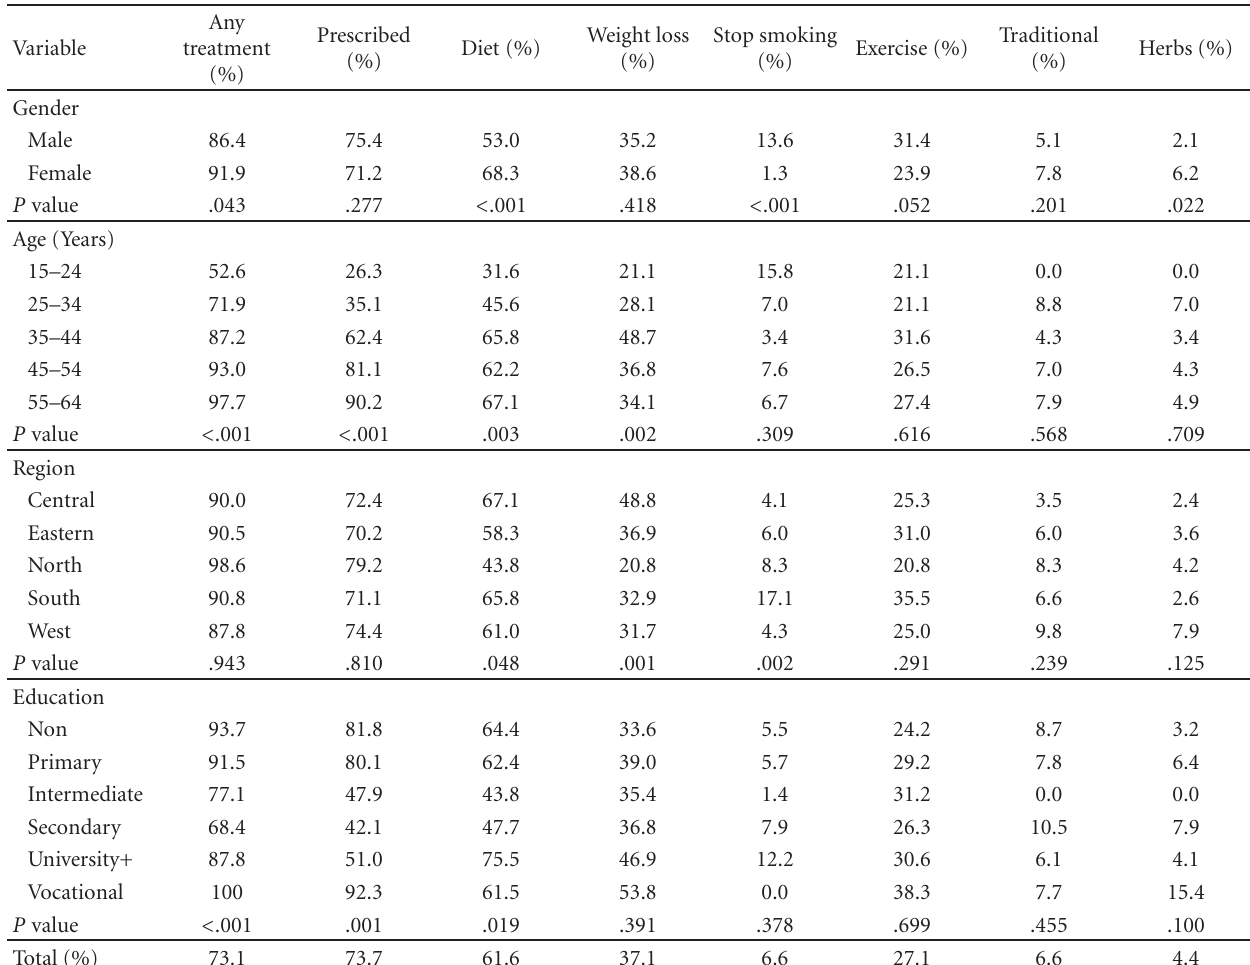
Table 4: Treatment modalities and practices of hypertensives ( n =